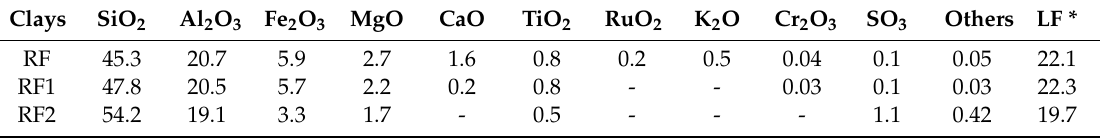
Table 1. Chemical composition (wt%) of the samples RF, RF1, and